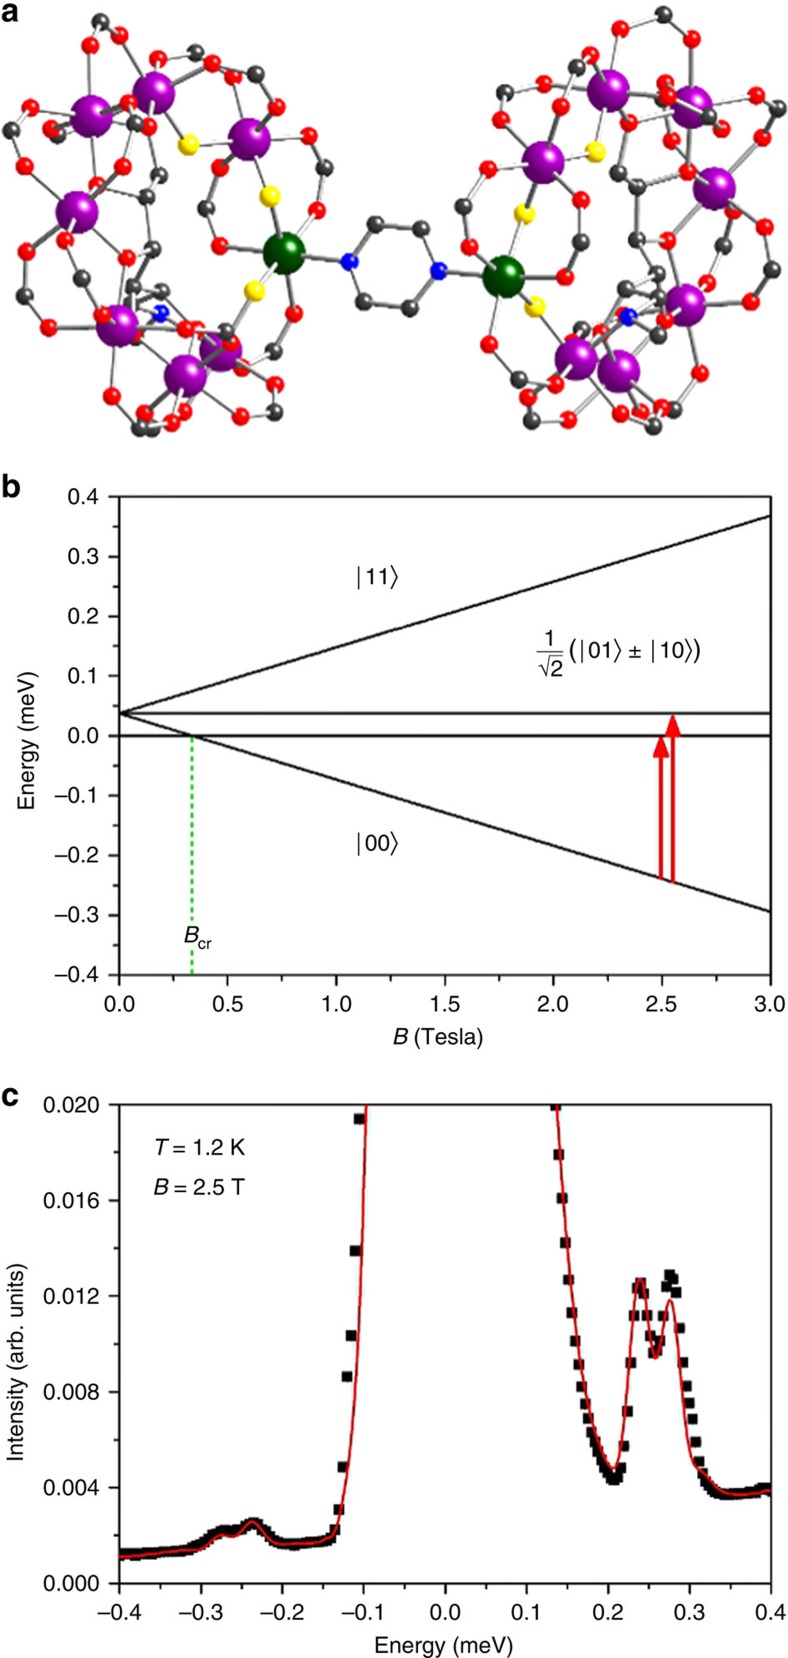
The (Cr7Ni)2 dimer.(a) Molecular structure of the supramolecular dimer of formula [Cr7NiF3(C7H12NO5)(O2CC(CH3)15)]2(N2C4H4) (magenta, Cr; green, Ni; yellow, F; red, O; light blue, N; grey, C; C(CH3)3 groups and all H atoms omitted for clarity), consisting of two purple-(Cr7Ni) AF rings, forming an angle of about 30°. The coupling between the rings is mediated by pyrazine, which directly links the two Ni ions. (b) Lowest-energy levels of the molecular dimer as a function of the applied magnetic field B, calculated by diagonalizing the microscopic spin Hamiltonian, equations (1 and 2). The arrows indicate the two transitions detected by in-field INS. |0> and |1> qubit states are encoded in the ground |S=1/2, M=±1/2> doublet of each ring. Above Bcr=0.34 T the dimer ground state is a factorized ferromagnetic state. In the first two excited states the total spins (S=1/2) of the rings are entangled and correspond to two Bell states. (c) Measured INS spectrum (black points) and calculations (red line) for a collection of (Cr7Ni)2 crystals at T=1.2 K and B=2.5 T applied along the y-vertical axis, with an incident neutron wavelength λ=7.5 Å and integrated over the full range of measured Q. Excitations in both energy-gain and energy-loss sides of the spectrum are clearly visible.